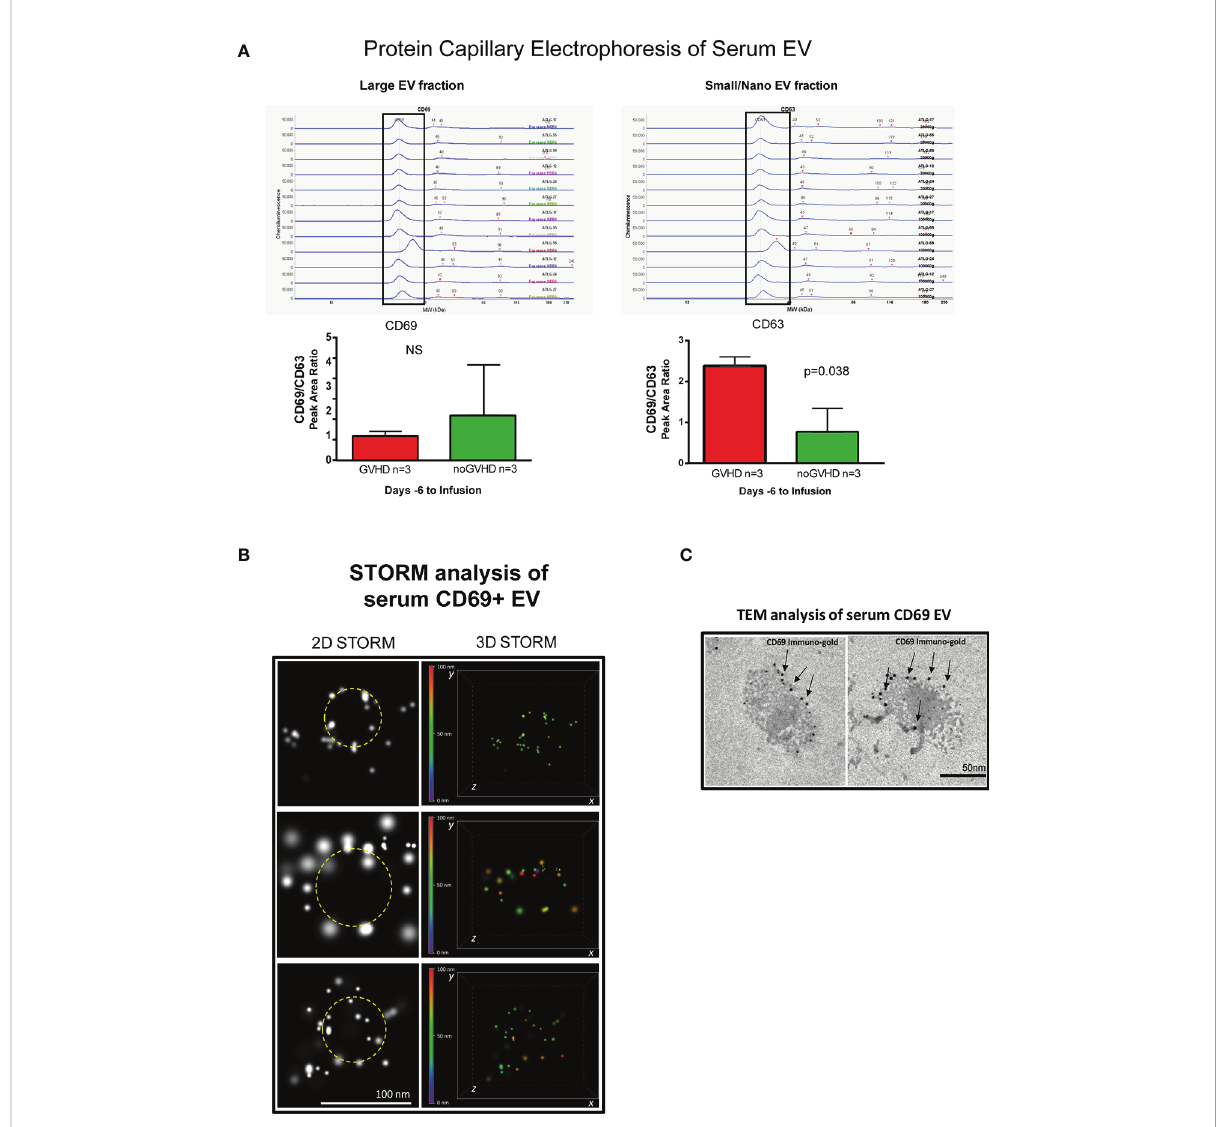
FIGURE 3 Detection of serum CD69+ EVs. (A) , Capillary electrophoresis protein analysis of EVs separated by ultracentrifugation at 100.000× g (small/nano EVs fraction) and 20.000× g (Large EVs fraction). (B) STORM analysis of serum EVs isolated by anti-CD9-conjugated latex beads pull-down. (C) , Immunogold-speci fi c CD69 electron microscopy analysis of EVs isolated by anti-CD9-conjugated latex beads pull-down. ns, not signi fi